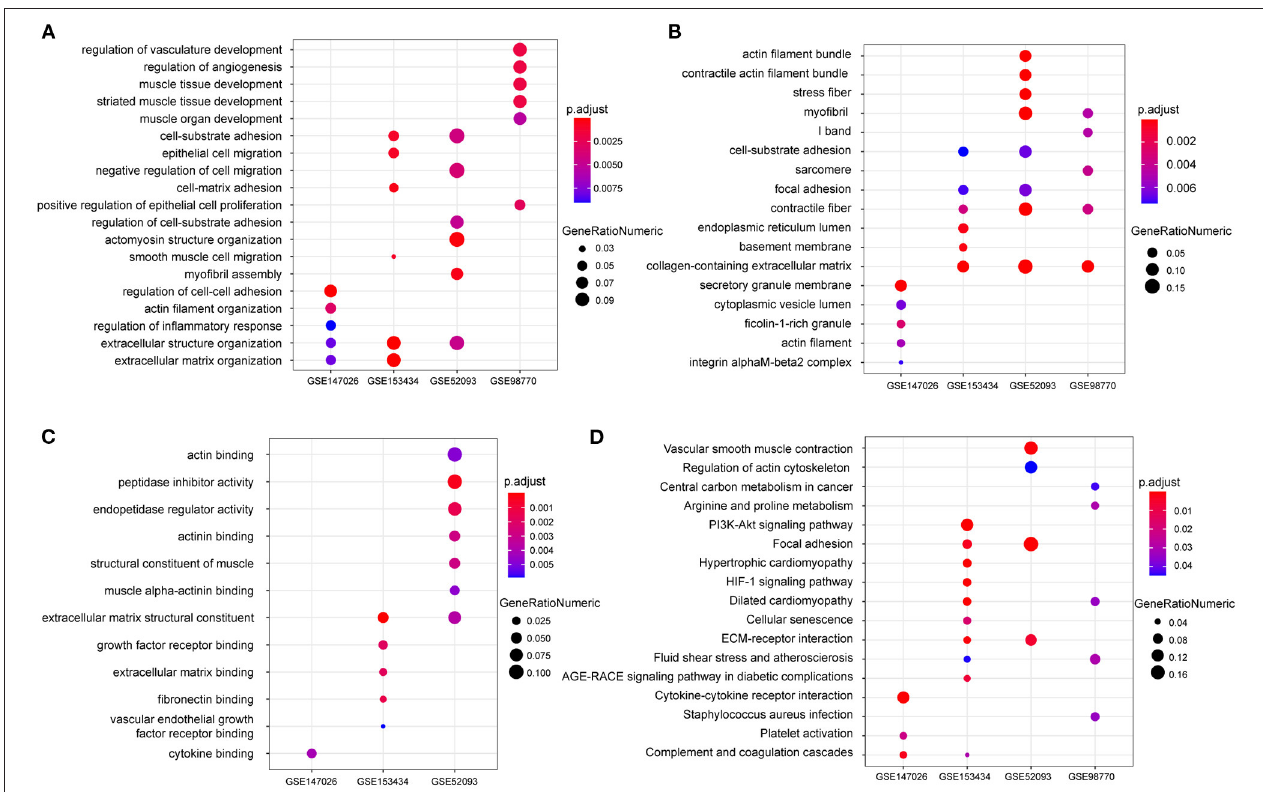
FIGURE 1 | The enrichment analysis shows the differentially expressed genes between the AD and normal groups. (A–C) GO analysis showing the differences of mRNA expression in the aorta between AD and normal groups on biological processes (A) cellular component (B) or molecular function (C) among the four GEO datasets GSE147026, GSE153434, GSE52093, and GSE98770. (D) KEGG enrichment analysis showing the dramatically altered pathways in AD among the indicated